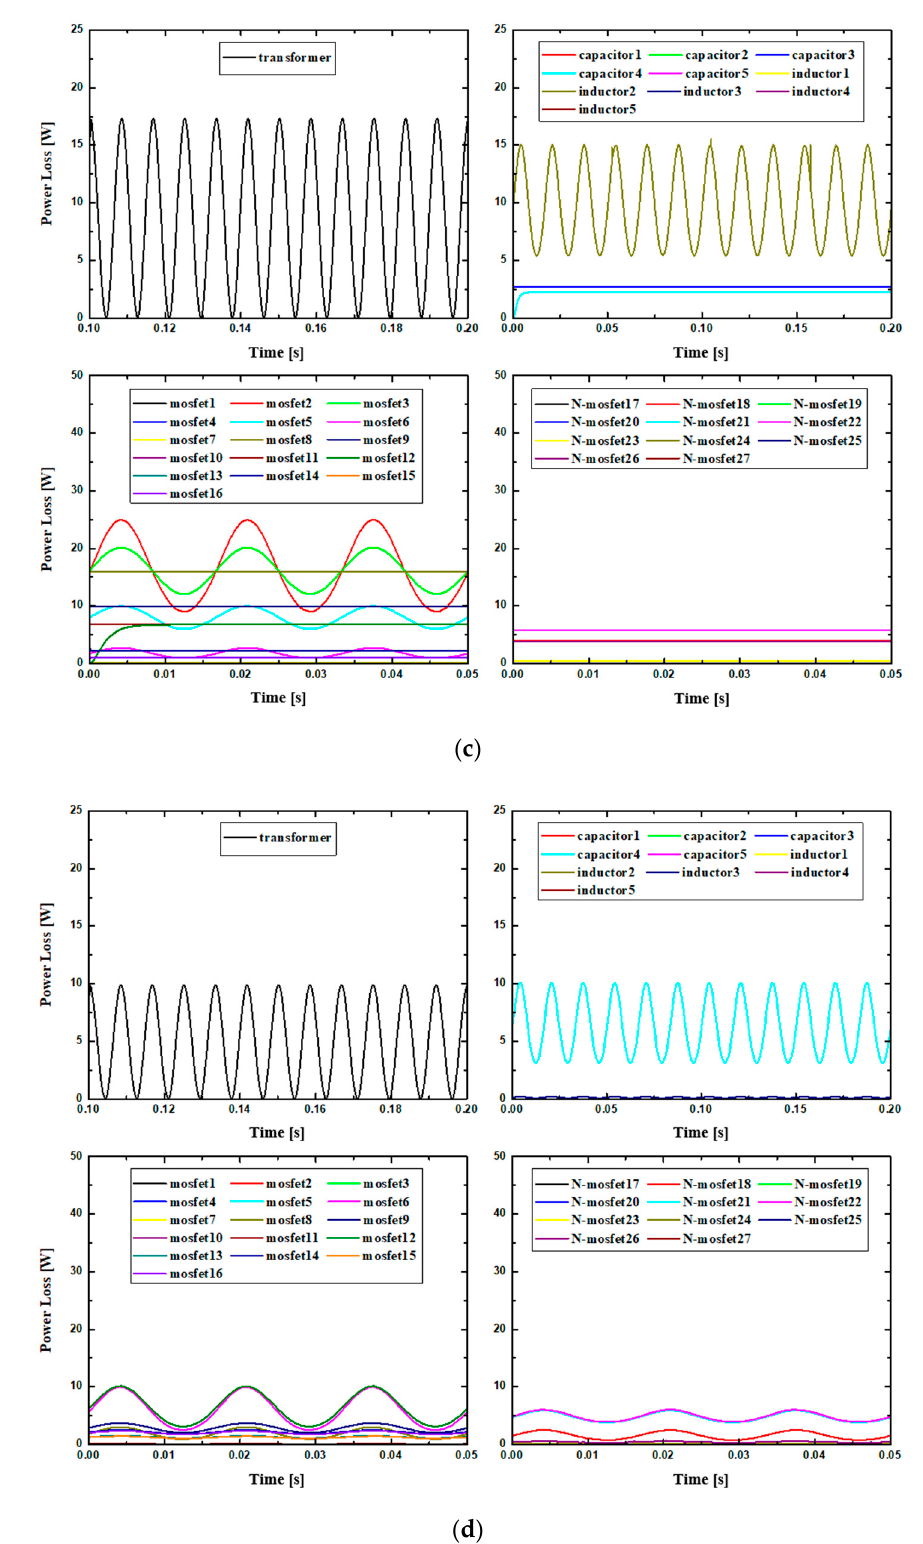
Figure 7. Power loss in the designed module; ( a ) Mode 1, ( b ) Mode 2, ( c ) Mode 3, and ( d ) Mode 4. The results of the heat flow analysis are shown in Figures 8–15 for the various operating modes. The conditions for this analysis included a cooling water flow of 6 LPM in the forward direction